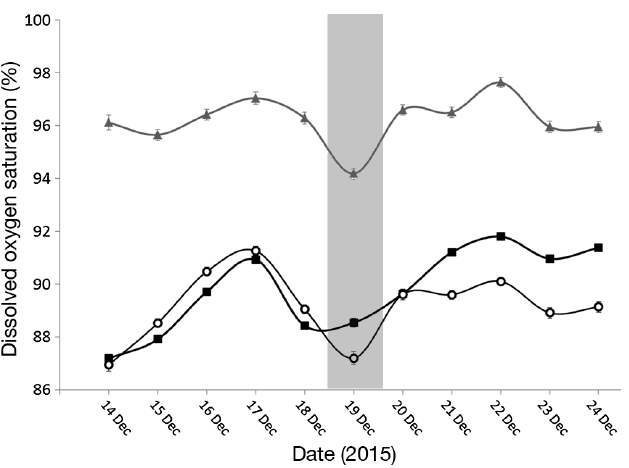
Fig. 3. Mean daily dissolved O 2 saturation in each cage type and at the reference site. ( m ) Reference conditions, ( j ) stan- dard cages and ( s ) large cages. Error bars represent 95% confidence intervals. The grey shaded area in the centre of the plot denotes a neap tidal cycle